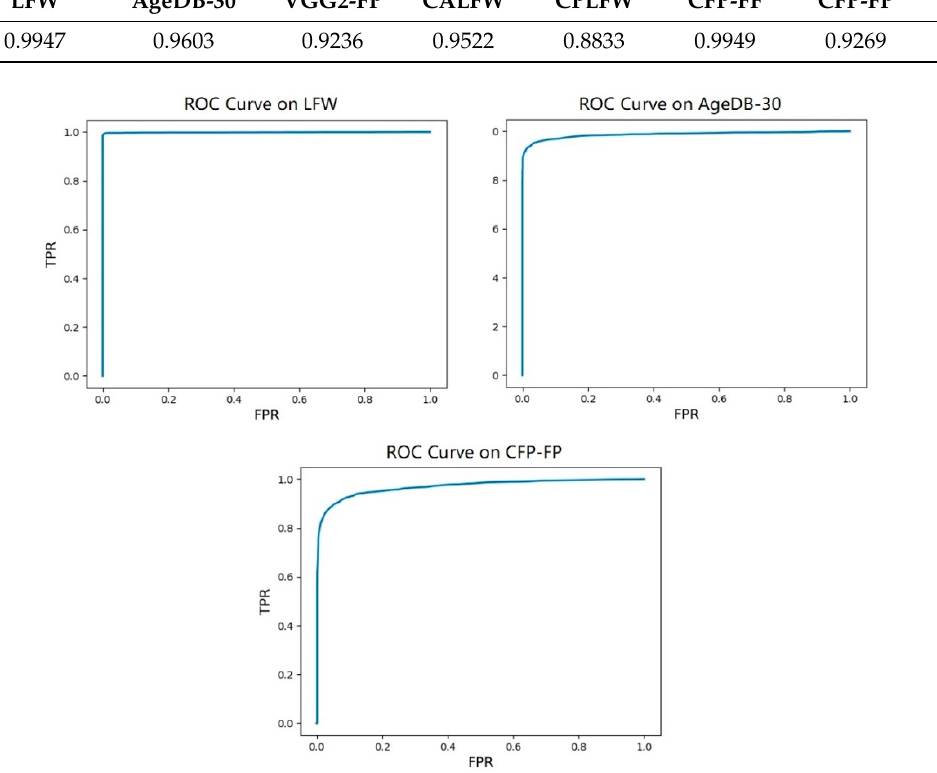
Figure 8. The ROC curves of the baseline on LFW, AgeDB-30, and CFP-FP. Combining the improved structures based on the channel attention mechanism pro- posed in Section 3.1, i.e., the depthwise SE (DSE) module, depthwise separable SE (DSSE) module, and linear SE (LSE) module, we conducted corresponding experiments of training and testing. Figures 9 and 10 show the change in loss and accuracy during training after utilizing different modules in the architecture. In the figures, the blue curve represents the baseline, the orange represents the model with LSE, the green represents the model with DSSE, the red represents the model with DSE, the purple represents the model with DSSE and LSE, and the brown represents the model with DSE and LSE. It can be seen from Figure 9 that the overall trend of training loss with different modules is consistent with the baseline. When magnifying the curves at the end, we can see that after utilizing the SE blocks, the training loss is lower than that of the baseline. Moreover, the model with LSE has the lowest drop in training loss, whereas the training loss with DSSE and LSE has the maximum drop. Figure 10 shows that accuracy of each model on LFW is higher than that of the baseline, and all are above